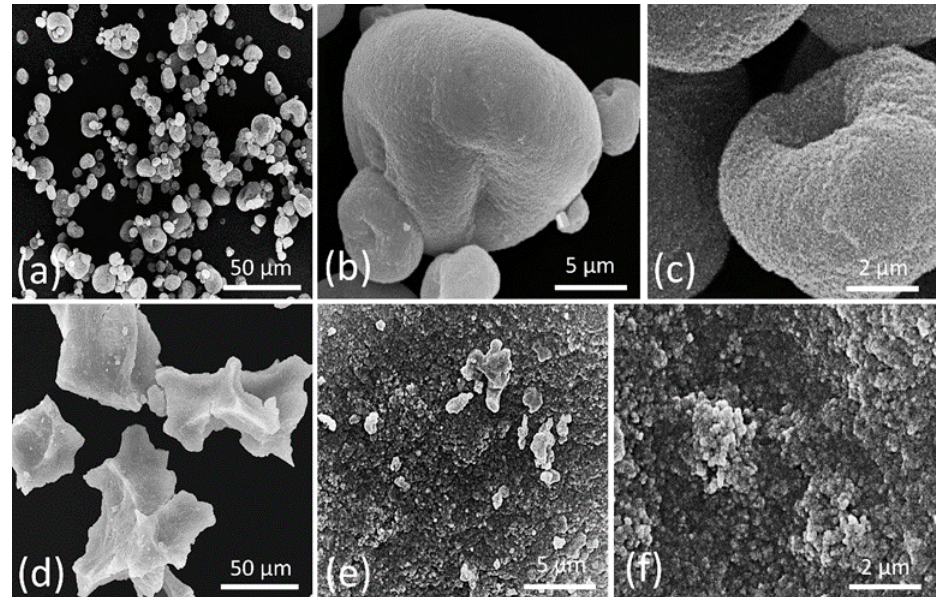
Figure 5. Scanning electron micrographs of Sepia officinalis melanin ( a – c ) and Pseudomonas putida